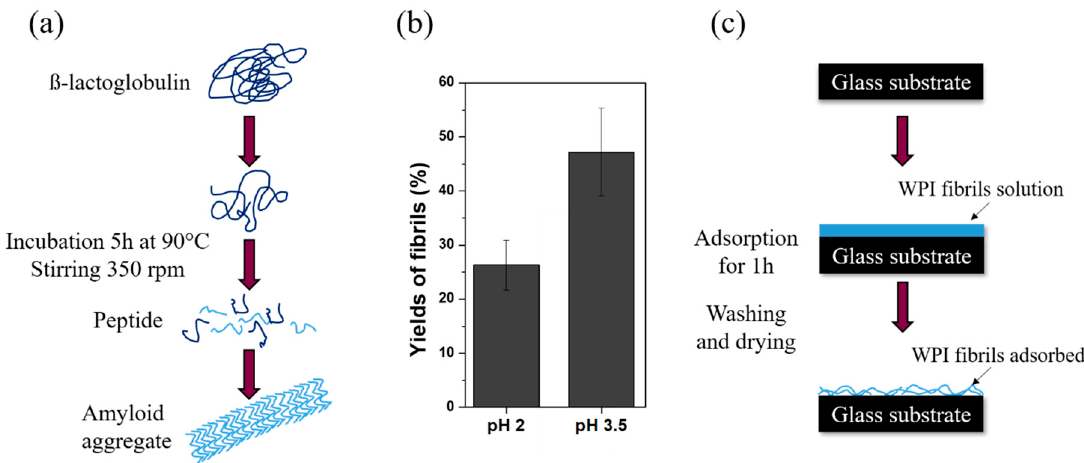
Figure 1. ( a ) Process of fibrils formation at pH 2 in solution; at pH 2, β -lactoglobulin denatures and hydrolyses at 90 °C. Specific peptides self-associate into the amyloid aggregates, which can consist of approximately three intertwined protofibrils. At pH 3.5, acid hydrolysis is reduced; therefore, non-hydrolyzed β -lactoglobulin assembles into worm-like aggregates, which are not amyloid but amyloid-like, and of different shape and morphology. ( b ) Fibrillar yield in solutions of different pH and ( c ) adsorption of whey protein isolate (WPI) fibrils on glass substrates.